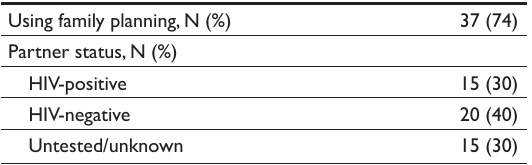
Table 2: Characteristics of sexually active